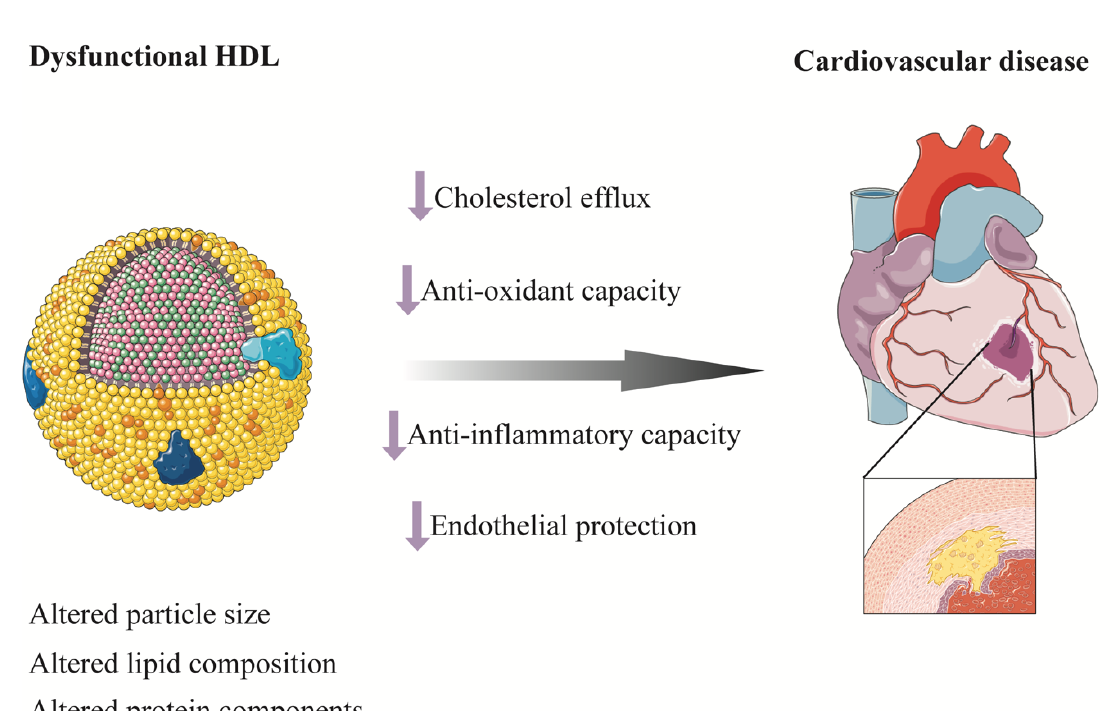
Figure 4. Dysfunctional HDL and cardiovascular disease. HDL are highly heterogeneous in size, structure, composition, and function. Altered lipid composition, protein components, and sizes result in dysfunctional HDL. Decreased cholesterol efflux from macrophages, antioxidant and anti-inflammatory capacity, and endothelial protective function of HDL induce atherosclerosis and cardiovascular disease. HDL, high-density lipoprotein.